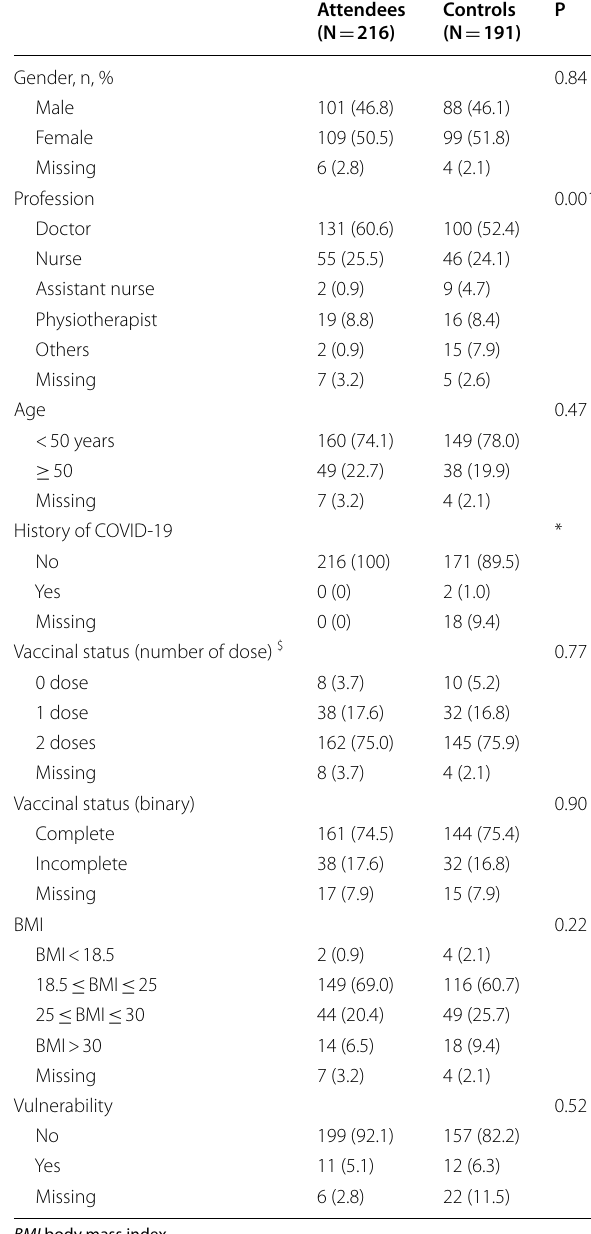
Table 2 Comparison of attendees and